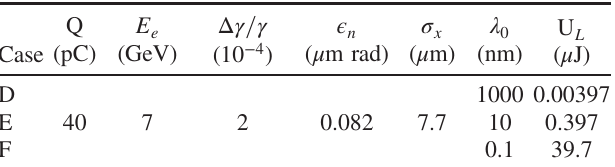
TABLE III. Interaction parameters XFELO- γ . Gaussian distribution for position and momentum of the electrons. N